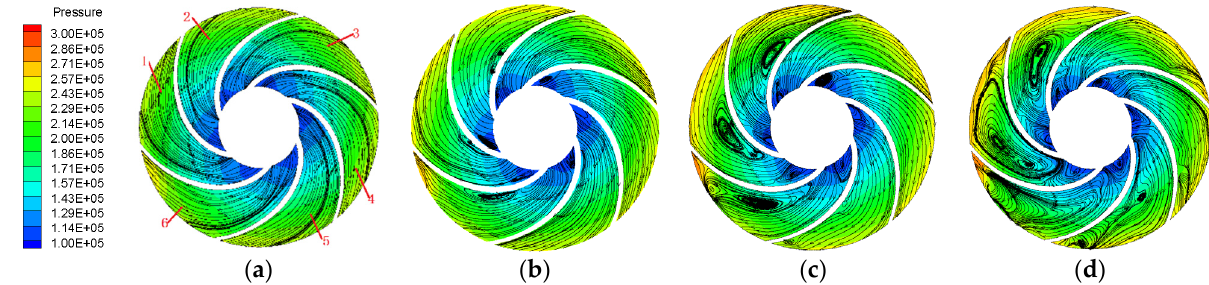
Figure 11. The pressure and streamline distribution in impeller under steady conditions ( a ) 0.8× Q d , ( b ) 0.6× Q d , ( c ) 0.4× Q d and ( d ) 0.2× Q d .